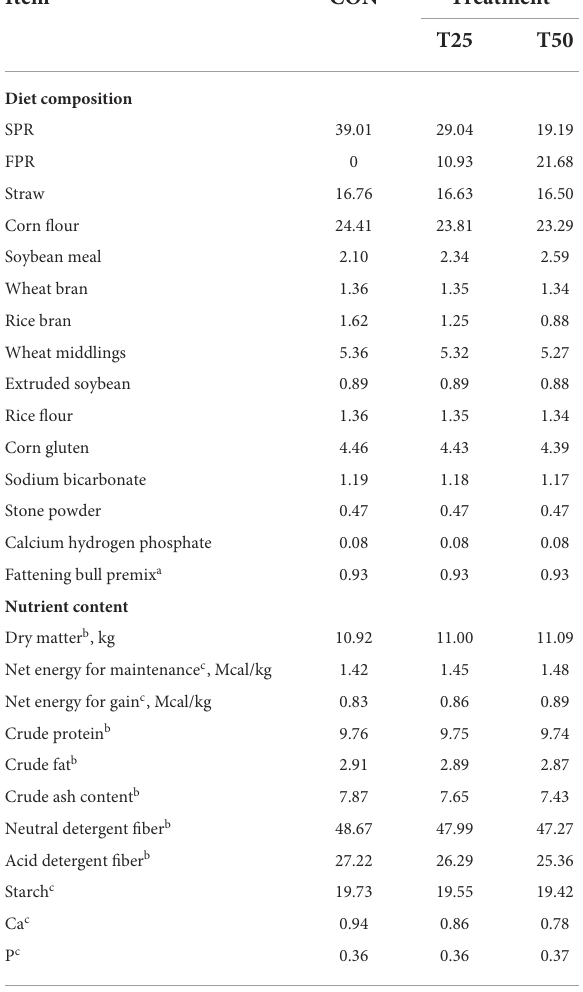
TABLE 1 Composition of the raw materials and nutrient content of the diet (%, DM).